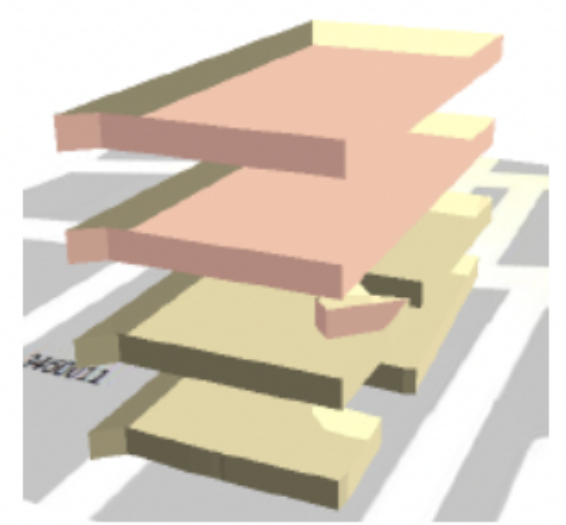
Figure 1. Sample 3D building with ownership data.